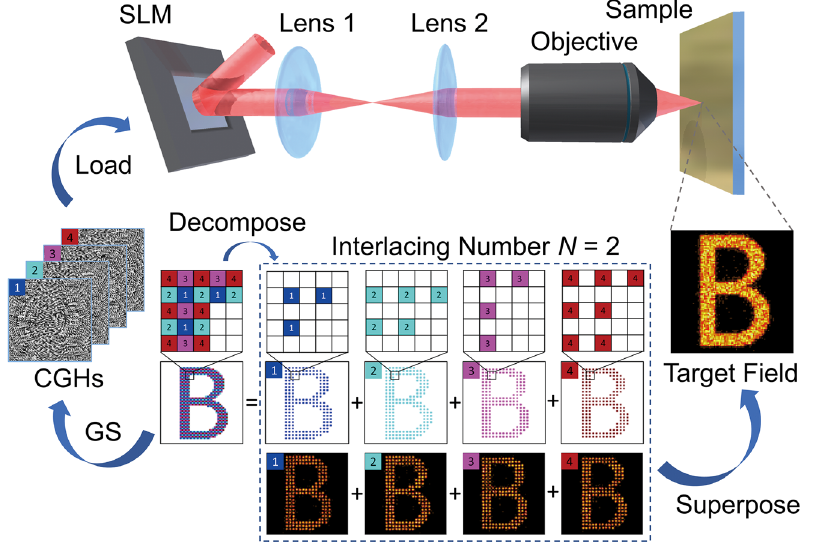
Figure 1: Schematic of SLM-based holographic femtosecond laser patterning system and illustration of interlacing- pattern method with interlacing number N =2. The target pattern “ B ” is decomposed through interlacing into four target subpatterns, and the corresponding four CGHs calculated using the GS algorithm are loaded onto the SLM successively in subsequent processing. Because the speckle noise of the optical fi elds corresponding to the four target subpatterns is effectively reduced, the uniformity and continuity of the target optical fi eld “ B ” are enhanced because of the superimposition effect, which improves the quality of the printed